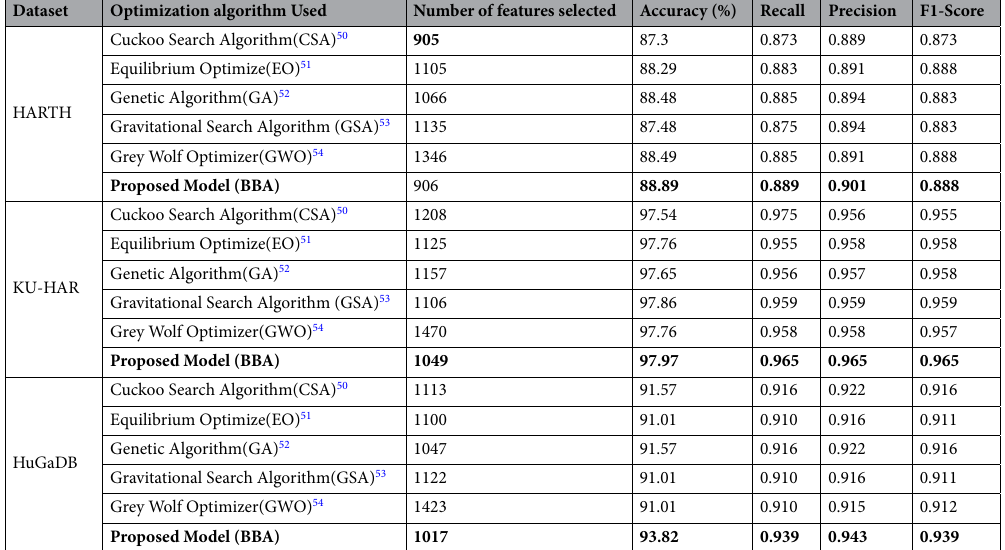
Table 9. Comparison of our proposed BBA based feature selection methodology with various well-known meta-heuristic feature selection algorithms used in the literature. (Here, bold indicates the least number of features selected and highest values of accuracy, Recall, Precision and F1-score attained for each of the HAR datasets).